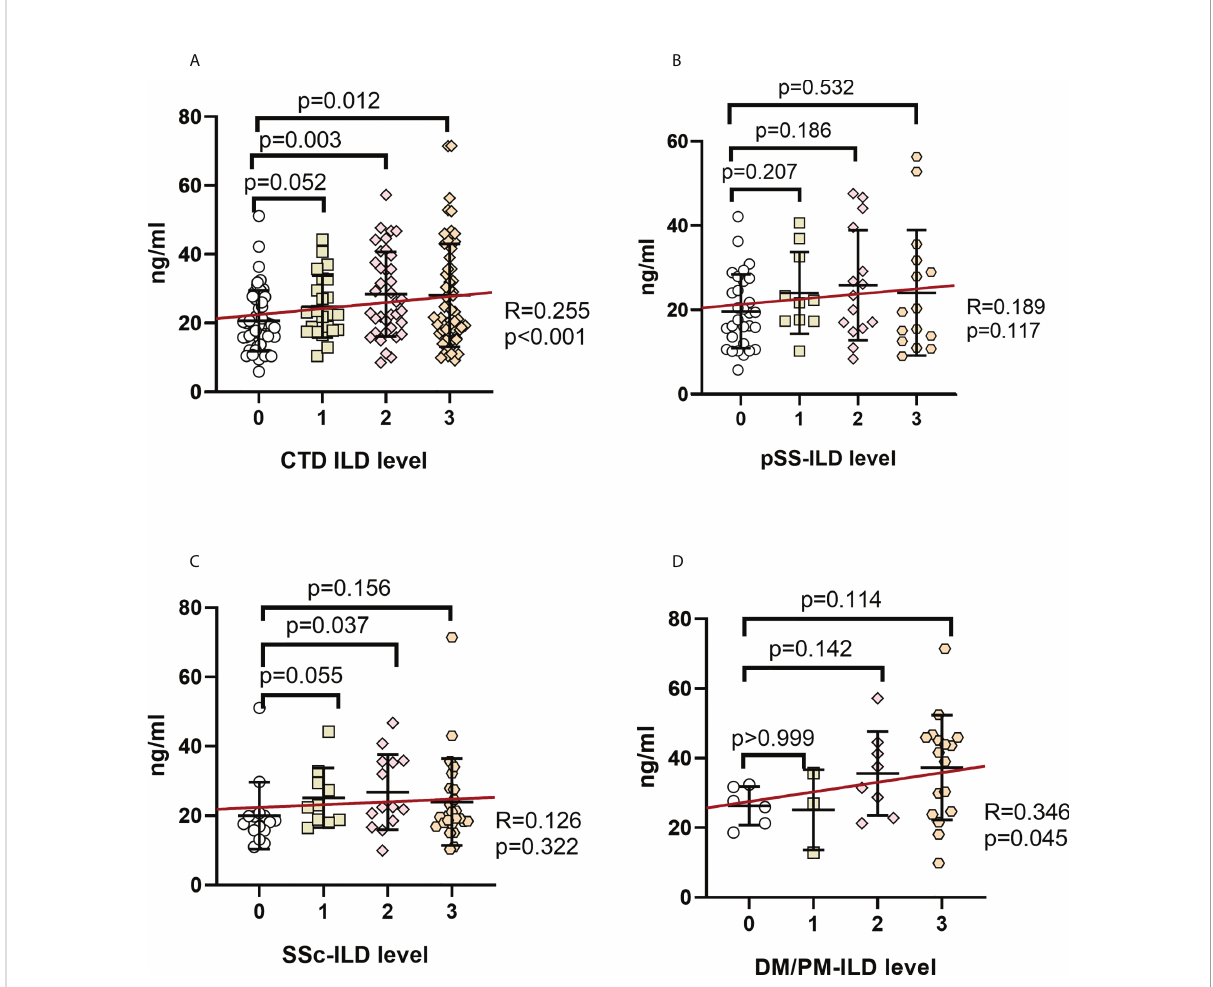
FIGURE 4 Correlation between serum MUC5B levels and ILD severity in patients with various autoimmune disease(s) (A) . CTD-ILD. (B). pSS-ILD. (C). SSc- ILD. (D) . DM/PM-ILD. The methodology used for these experiments was identical to those described in the legend for Figure